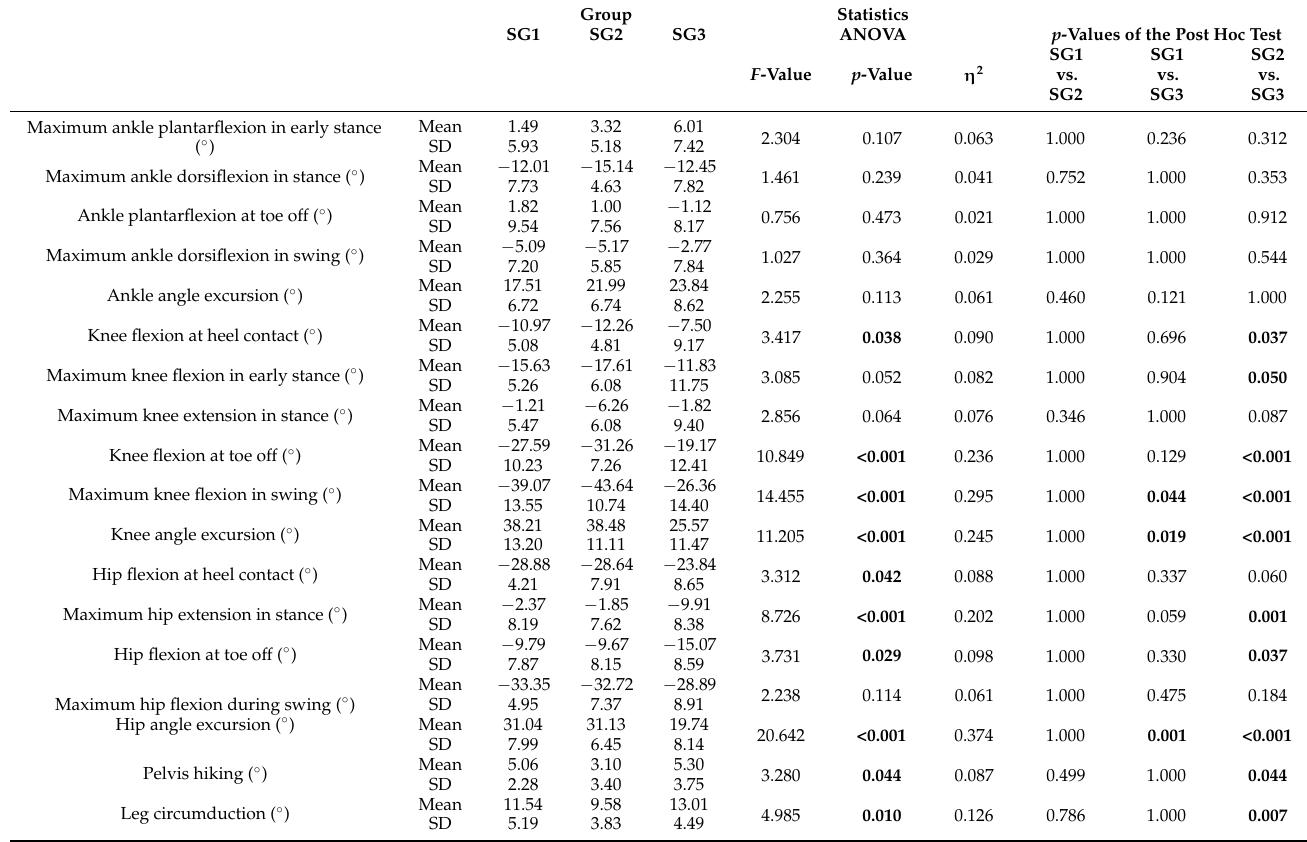
Table 3. Representative kinematic parameters in paretic lower limb during walk in the three